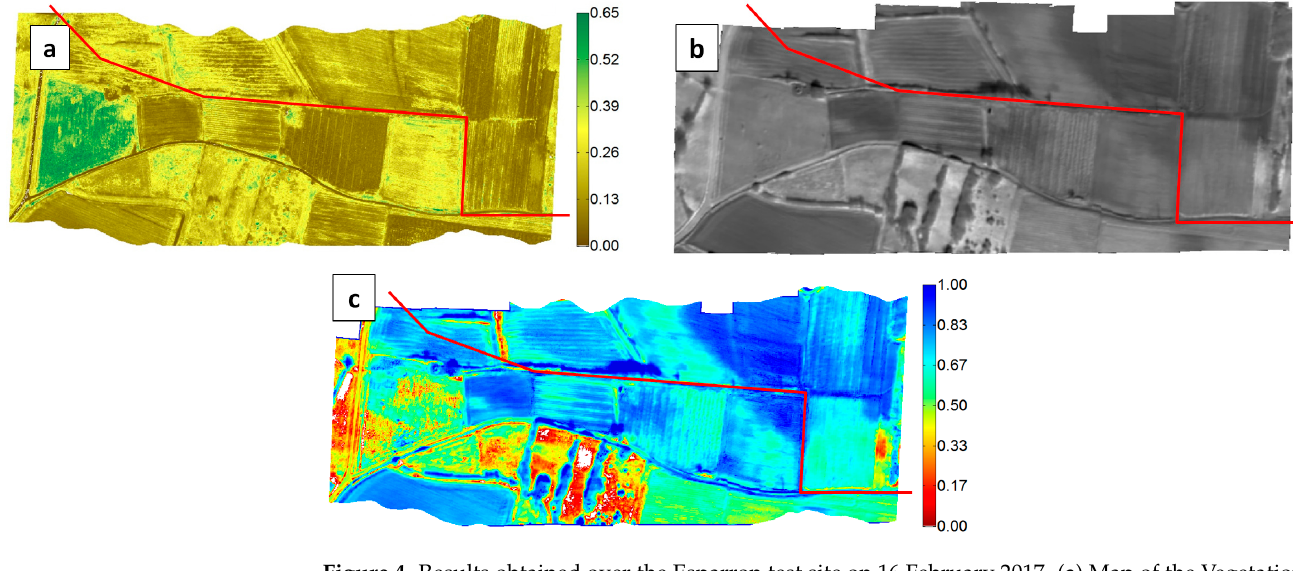
Figure 4. Results obtained over the Esparron test site on 16 February 2017. ( a ) Map of the Vegetation Index OSAVI. ( b ) Thermal Infrared mosaic (TIR) (dark/clear pixels correspond to low/high brightness temperatures). ( c ) Inferred map of the water index WI according to Equation (1) (the underlying 2D scatterplot of the normalized brightness temperature vs. Vegetation Index is in Figure 2b). The pipe position is shown in red in the three images.